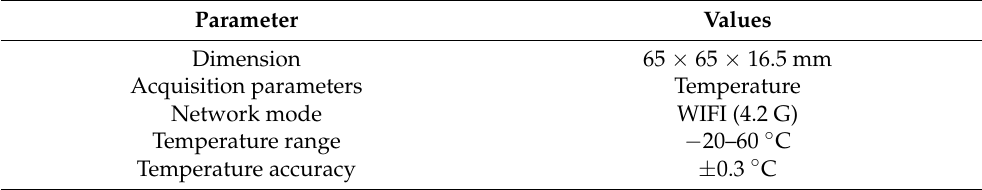
Table A1. Shows the sensor parameters in the monitored residential building. Sensor parameters.